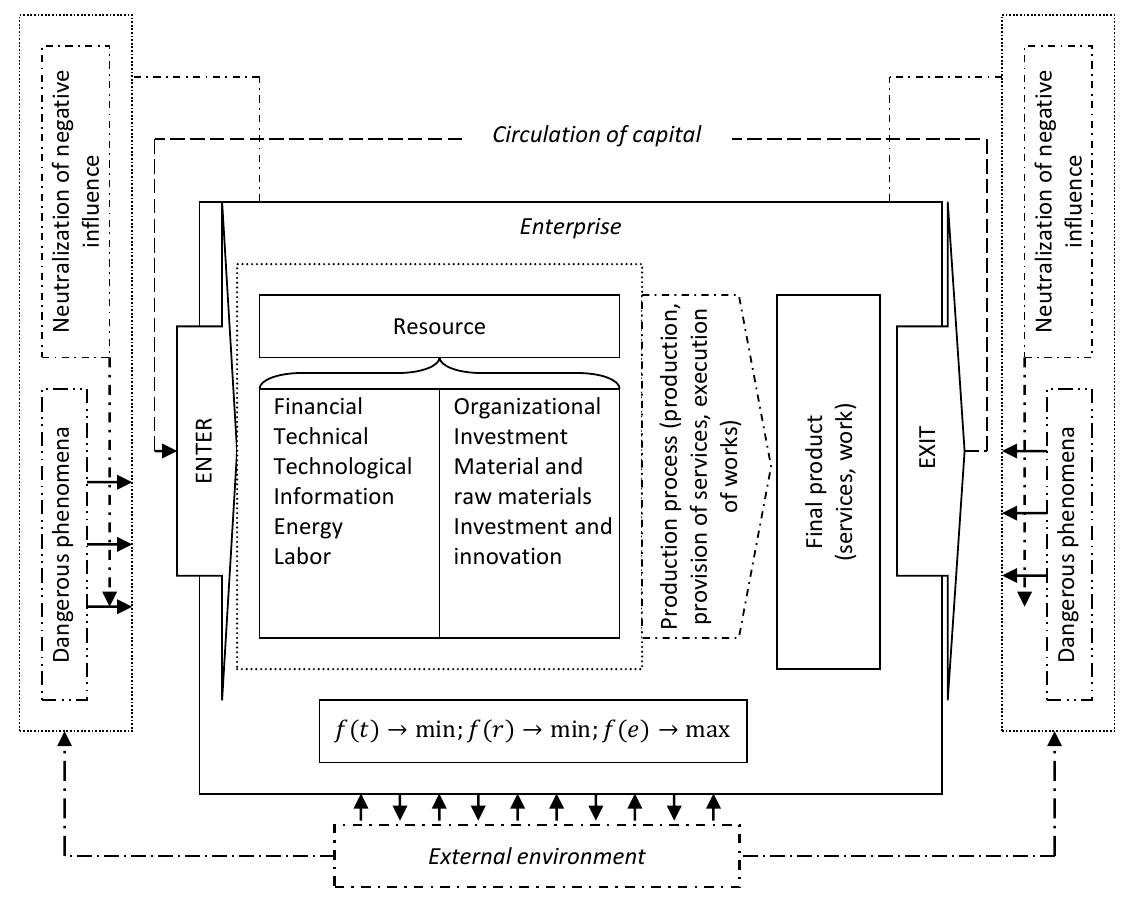
Figure 1. Enterprise economic security: simulation model of the